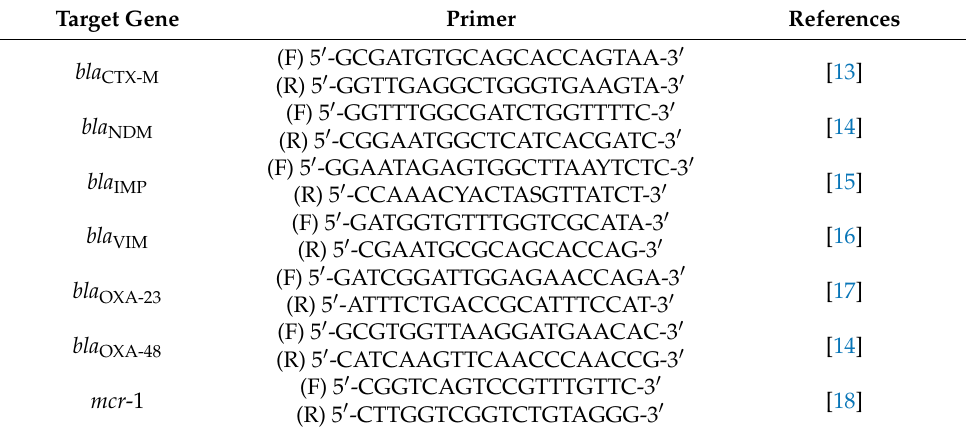
Table 1. PCR primers.